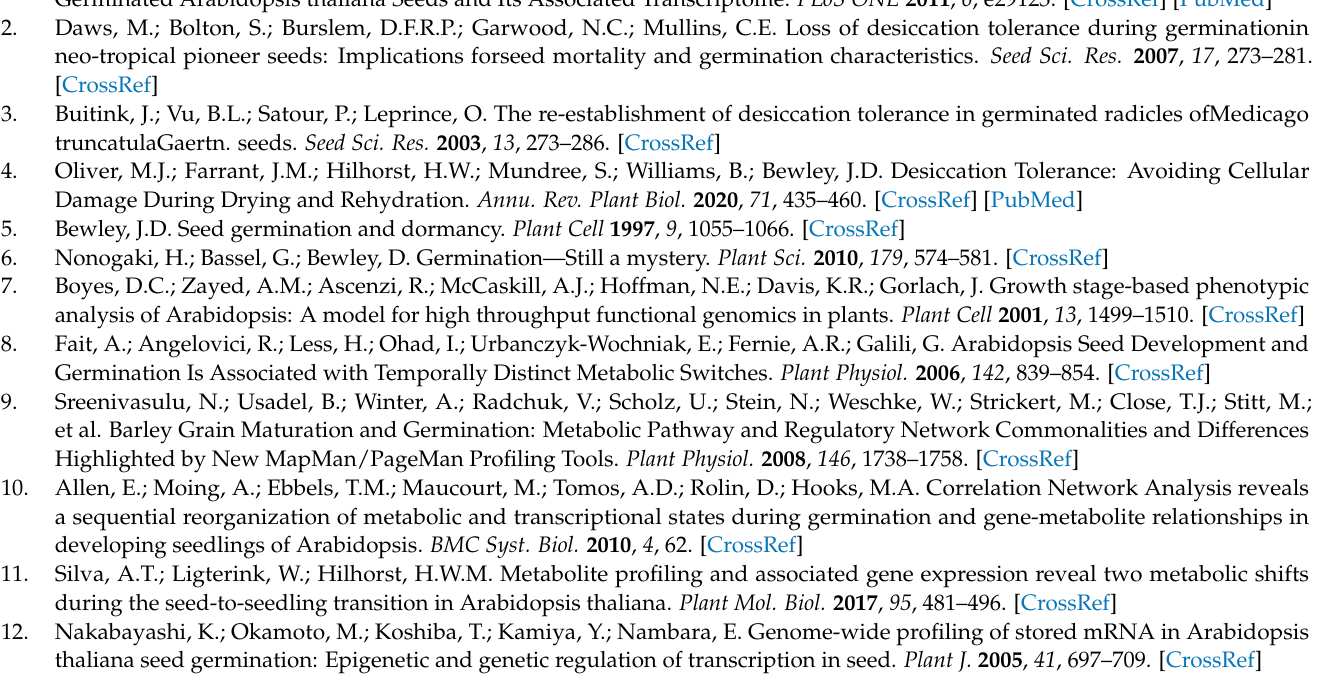
Table S11: List of primers used for RNA quality check and